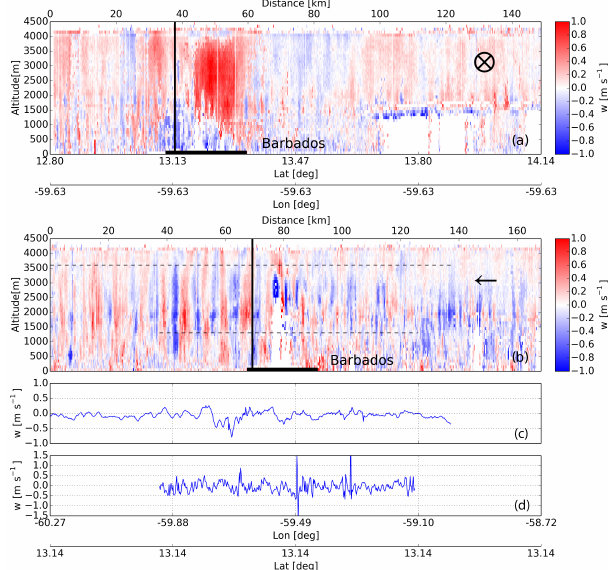
Figure 11. (a) Retrieved vertical wind speed by the DWL as a func- tion of the latitude and longitude from leg 1 (19:53 to 20:06LT), together with the latitude at which legs 2 (21:49 to 22:05LT), 3 (22:16 to 22:34LT) and 4 were flown (22:46 to 23:01LT) (solid line). (b) Retrieved vertical wind speed by the DWL as a function of the latitude and longitude from leg 2, the intersection position with the 1st leg (solid line) and the legs 3 and 4 are shown (dashed line). (c, d, e) In situ vertical wind speed corresponding to the legs 2, 3 and 4. The average wind inflow direction is indicated on the upper- right corner of panels (a) and (b) . Barbados indicated in both plots with a horizontal solid black